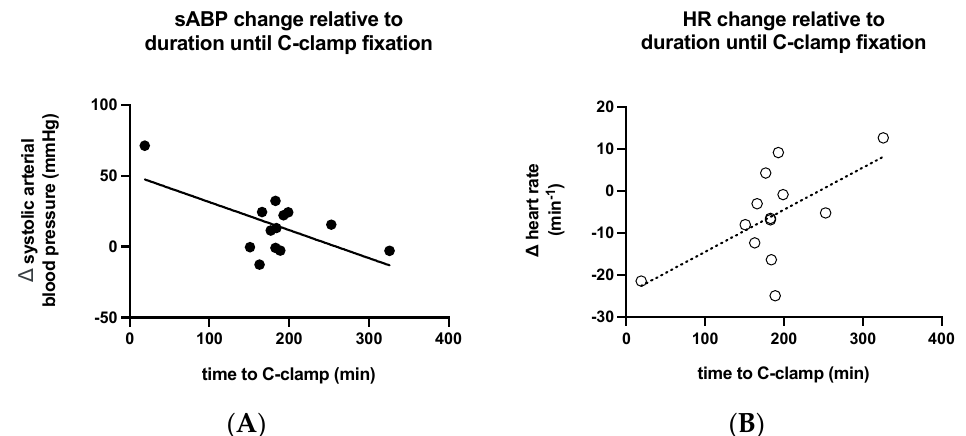
Figure 3. Relation of the magnitude of the effect on ( A ) sABP and ( B ) HR and time passed until C-clamp application. The earlier C-clamp application was performed, the greater the effect regarding sABP elevation. The earlier C-clamp application was performed, the greater the effect of HR reduction.